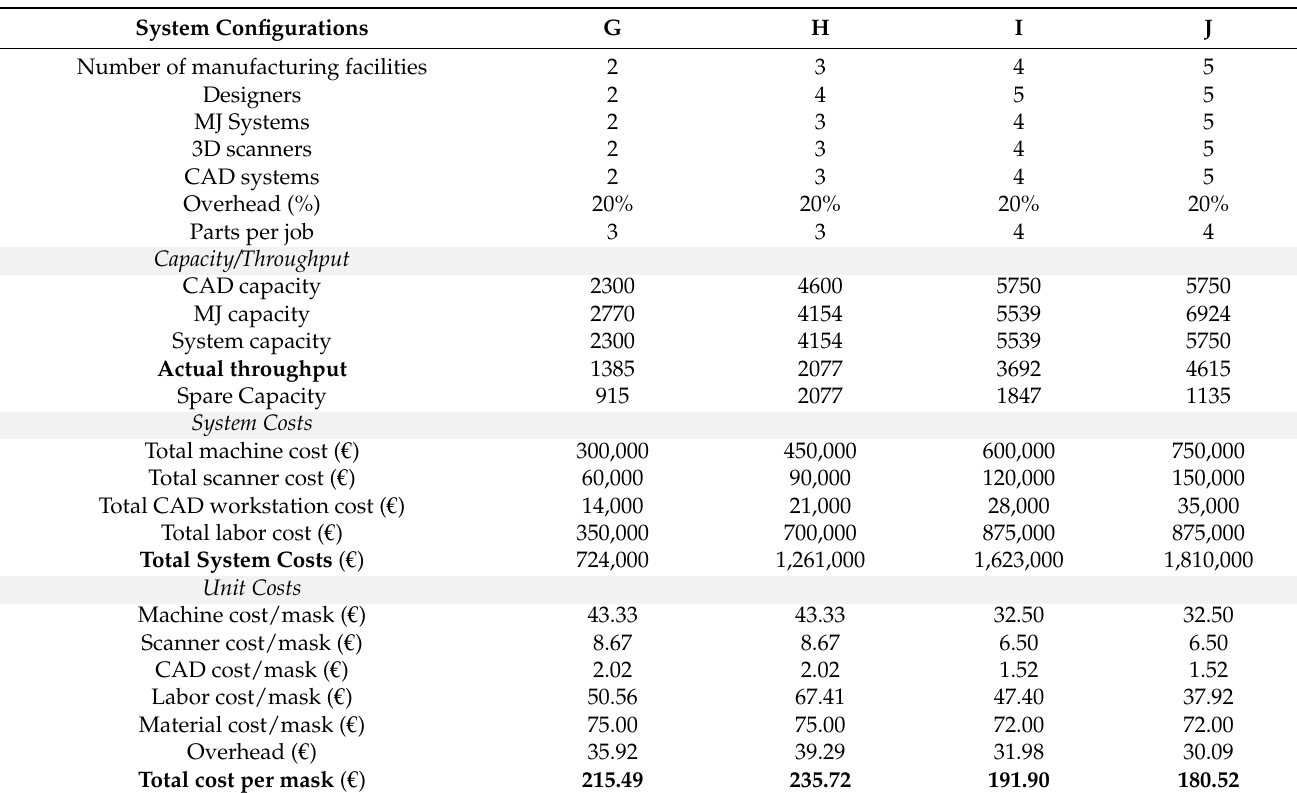
Table 6. Cost analysis for different system configurations of a distributed manufacturing